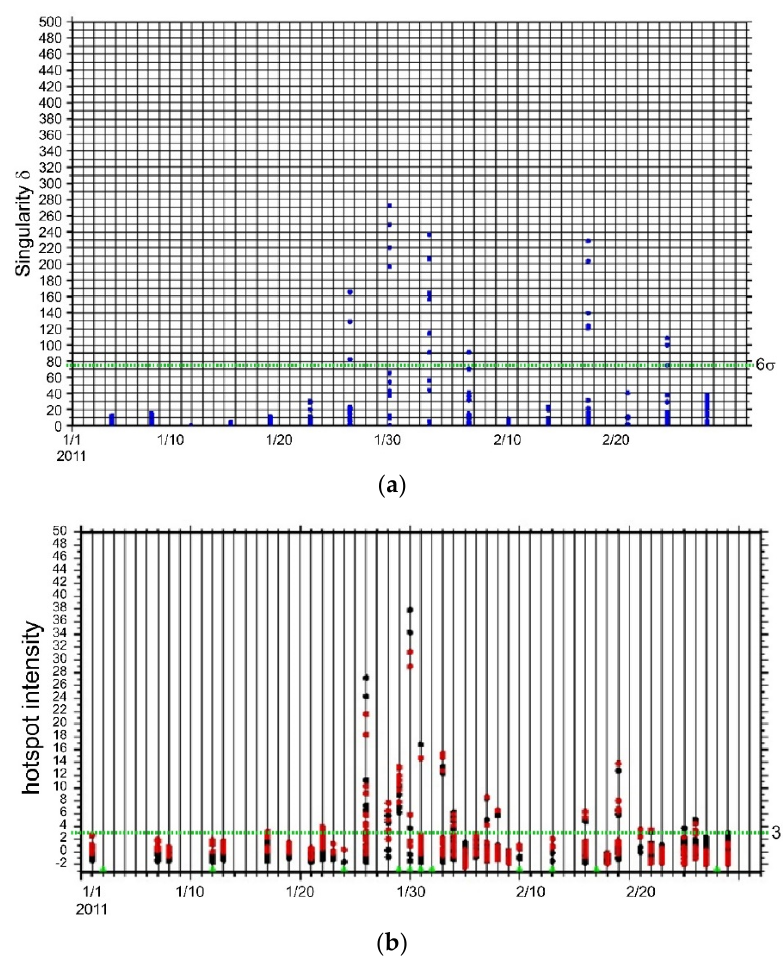
Figure 10. Temporal variation of singularity and RST VOLC at the summit crater of Shinmoedake during January–February 2011 in UT. ( a ) Singularity with this study for cloud detection; ( b ) hotspot intensity defined by RST VOLC .